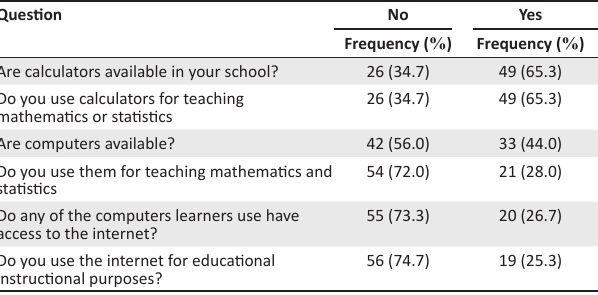
TABLE 2: Access to technology. Question